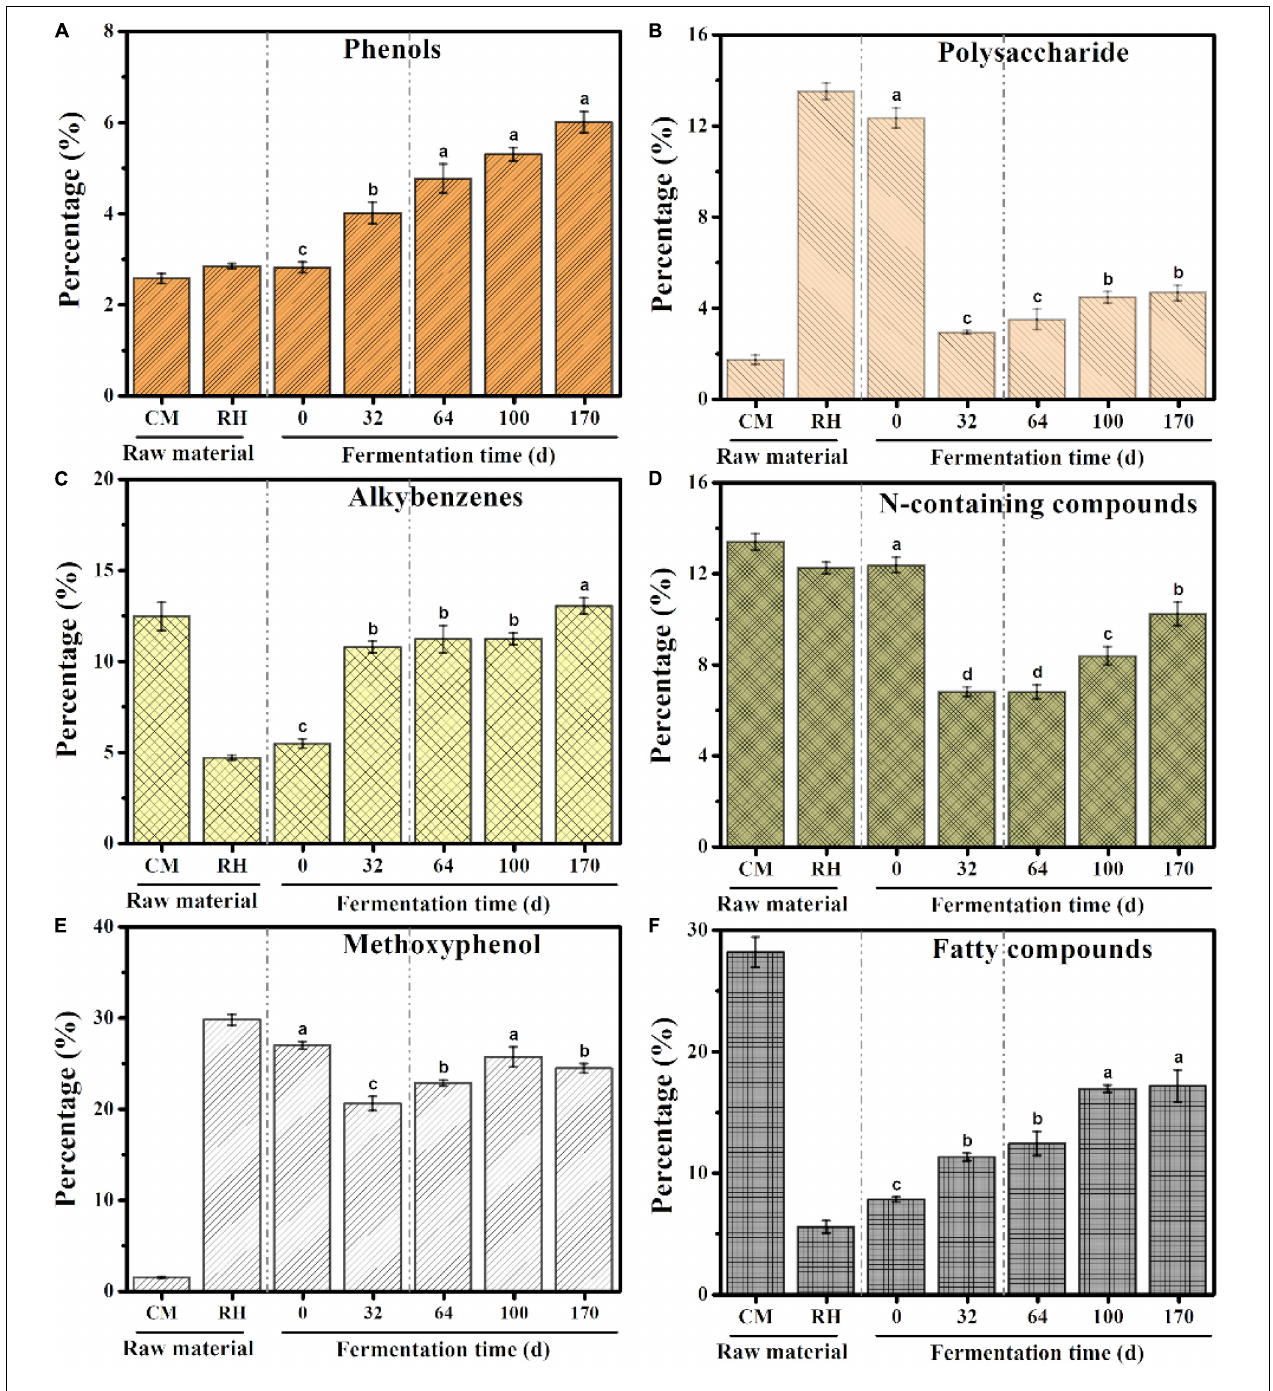
FIGURE 4 | Cumulative abundance for the main groups of pyrolysates during ectopic fermentation systems (EFS): (A) Phenols; (B) Polysaccharide; (C) Alkybenzenes; (D) N-containing compounds; (E) Methoxyphenol; (F) Fatty compounds. Histograms that do not share a letter are significantly different ( p <